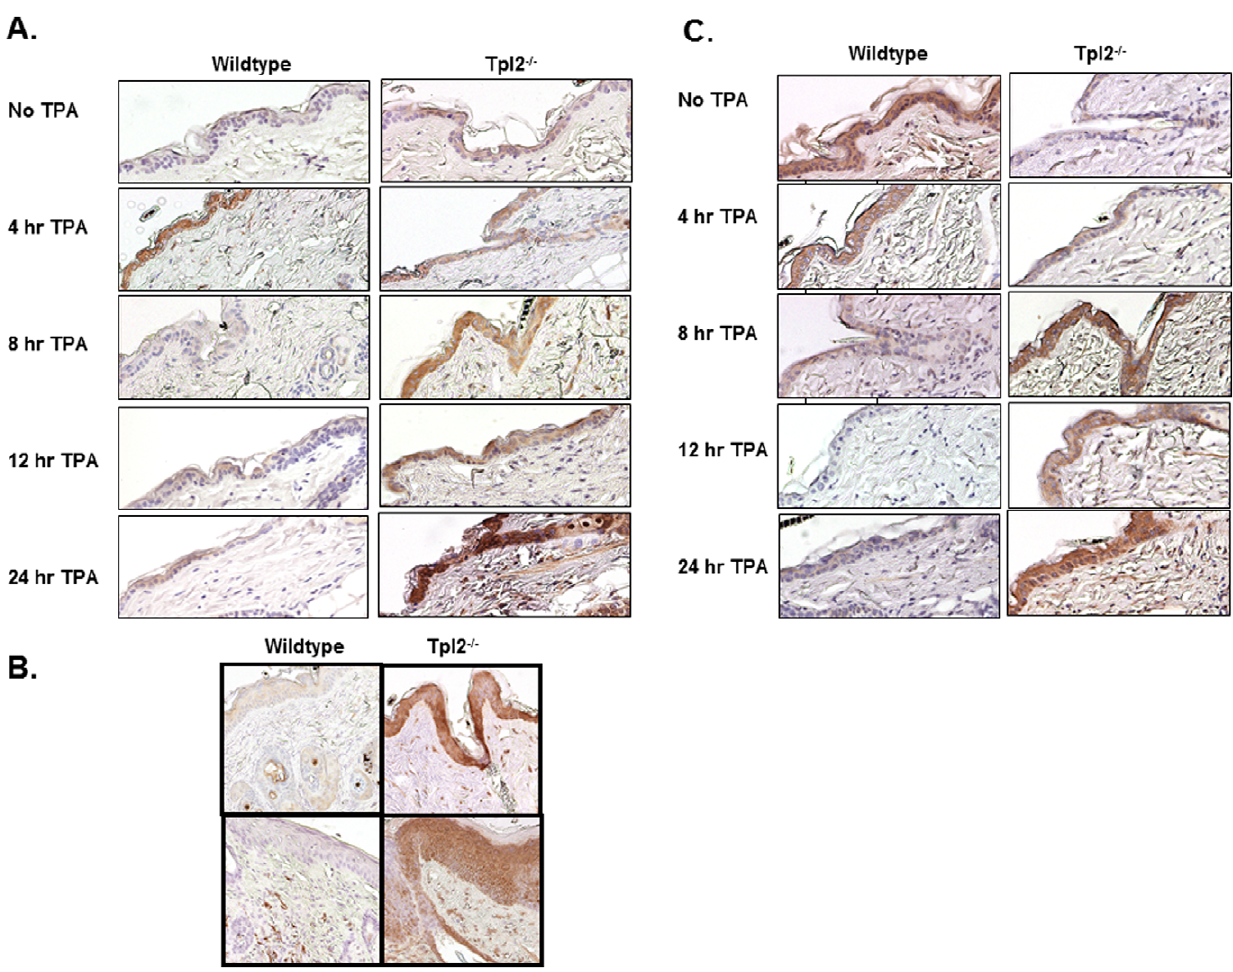
Figure 4. EP2 and EP4 receptor expression is heightened in epidermis and papillomas from Tpl2 2 / 2 mice. Shaved wildtype and Tpl2 2 / 2 mice were treated with TPA (10 m g) for 0, 4, 8, 12, or 24 hours and analyzed for expression of EP2 (Figure 4A) or EP4 (Figure 4C). Additionally, papillomas from wildtype and Tpl2 2 / 2 mice were analyzed for expression of EP2 (Figure 4B). Magnification=10X.